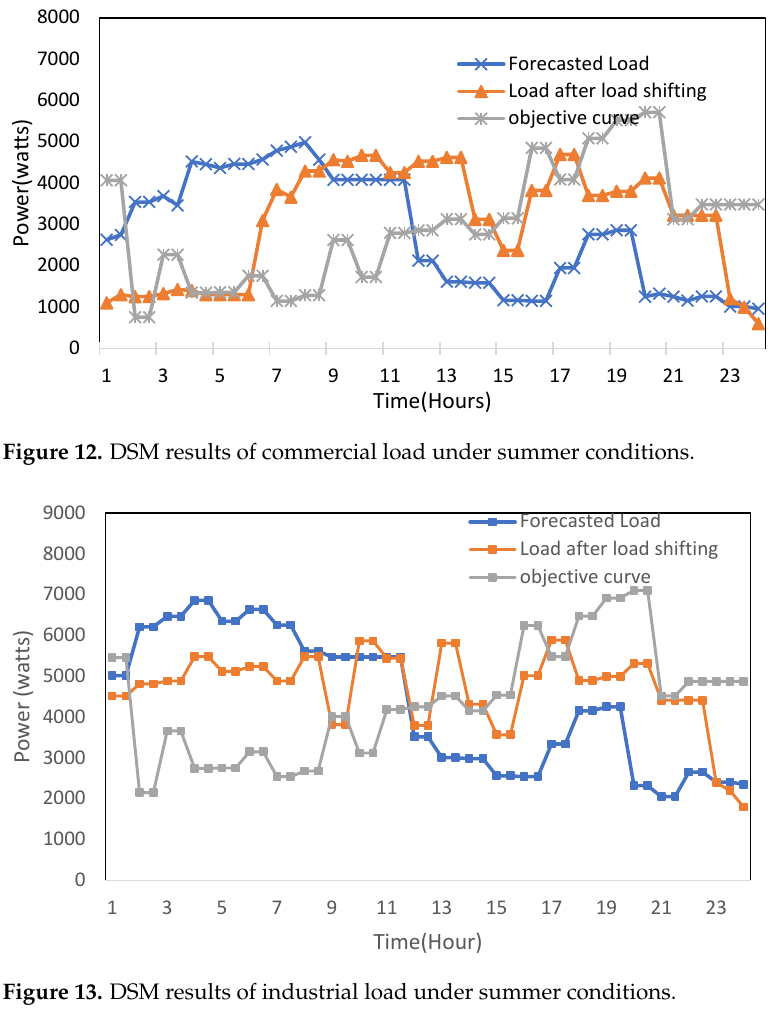
Figure 11. DSM results of residential load under summer conditions.